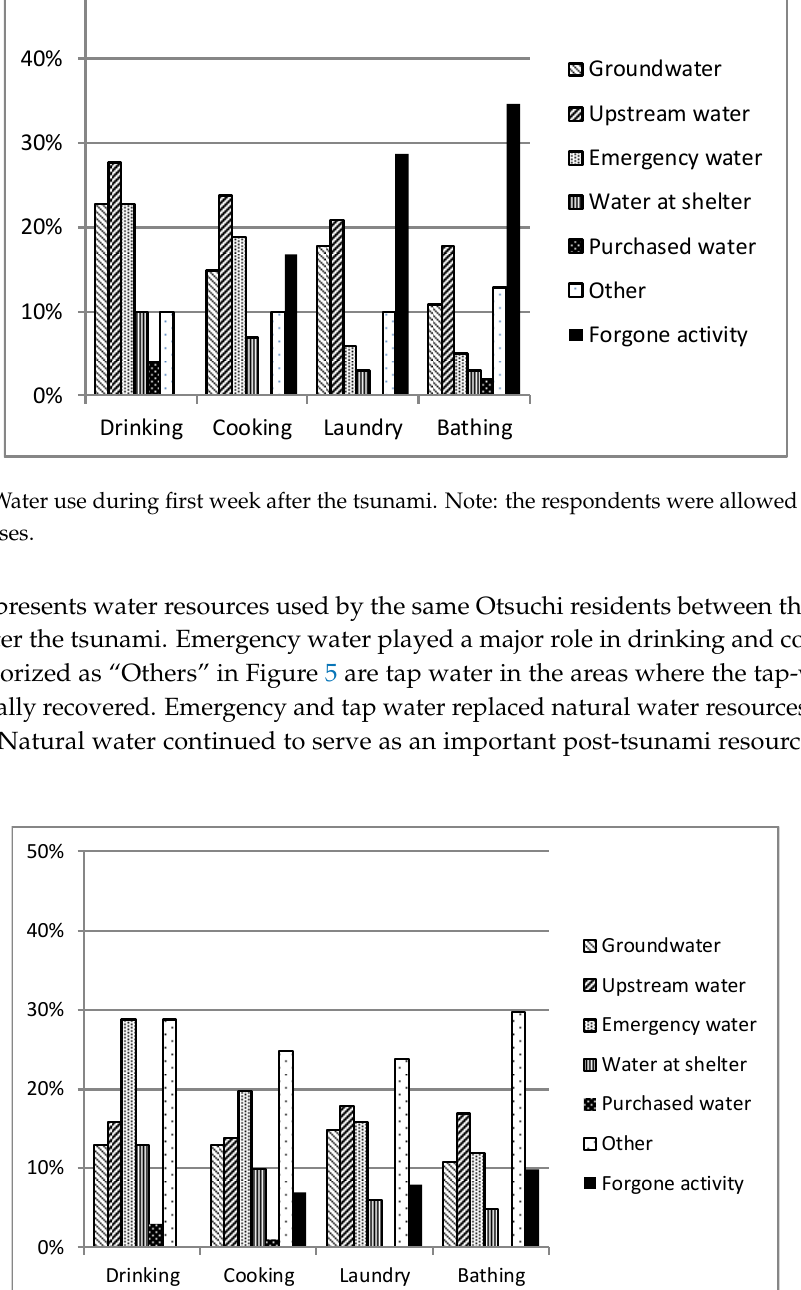
Figure 5. Water use during second–fifth weeks after the tsunami. Note: the respondents were allowed to choose multiple uses.